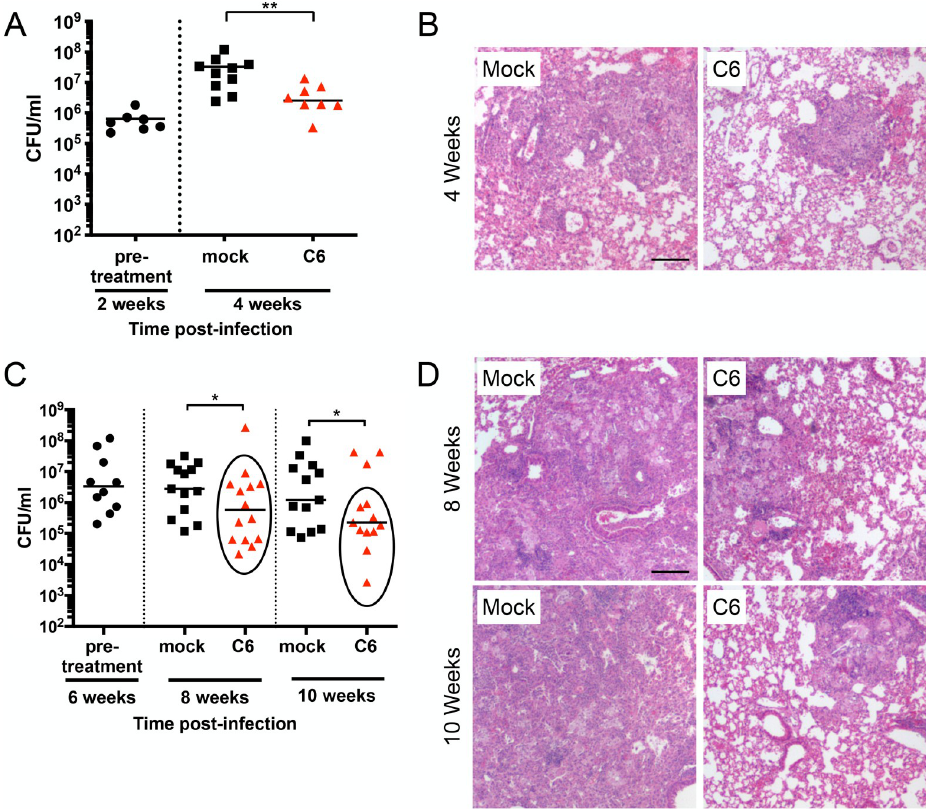
Fig 4. C6 inhibits Mtb growth in vivo. (A and B) C6 inhibits Mtb growth in a short-term infection model. C3HeB/FeJ WT mice were infected with Mtb for 2 weeks (pre-treatment), before mock treatment or treatment with 250 mg/kg C6 (5 days/week via oral gavage) for a further 2 weeks. (A) shows CFUs from lung homogenates plated at 2 or 4 weeks post-infection. p -values were obtained with a Mann–Whitney statistical test. �� p < 0.01. (B) shows lung pathology in the infected mice, with lung samples obtained from animals 2 weeks or 4 weeks post-infection, fixed, and processed for hematoxylin and eosin staining. Scale bar, 200 μ m. (C and D) C6 decreases Mtb load in a longer-term infection model. C3HeB/FeJ WT mice were infected with Mtb and infection allowed to establish for 6 weeks. Mice were then mock treated or treated with 250 mg/kg C6 by oral gavage 5 days/week for 2 or 4 weeks (8 or 10 weeks total infection). Lungs were homogenized and plated for CFUs at indicated time points, shown in (C). p -values were determined by a Mann– Whitney statistical test on the mock versus circled C6-treated population. � p < 0.05. (D) shows lung pathology in infected mice, with lung samples obtained from animals 6, 8, or 10 weeks post-infection, fixed, and processed for hematoxylin and eosin staining. Scale bar, 200 μ m. The numerical data underlying the graphs shown in this figure are provided in S1 Data. CFU, colony-forming unit; Mtb, Mycobacterium tuberculosis ; WT,